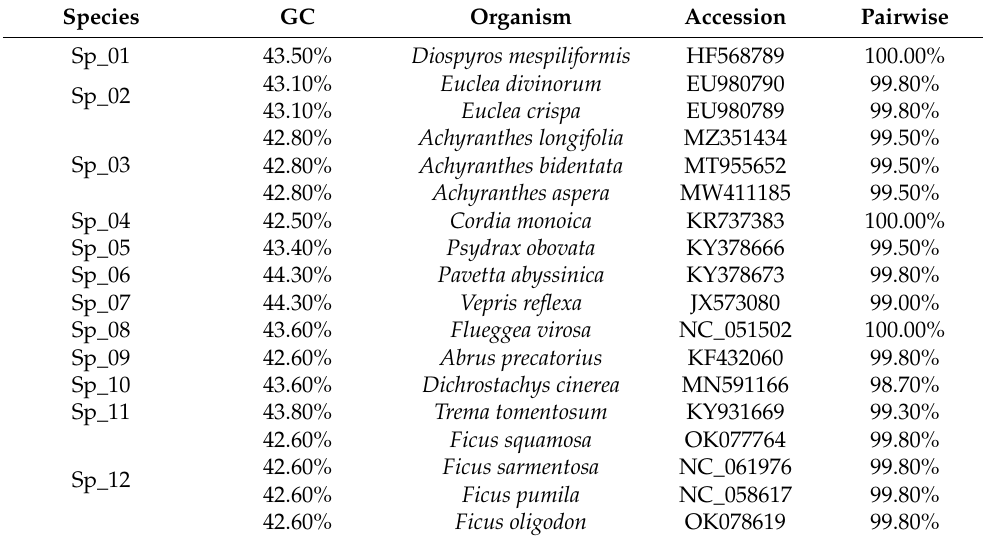
Table 1. Blast results of the rbcL sequences of 12 rare species of the Faifa mountains. Species GC